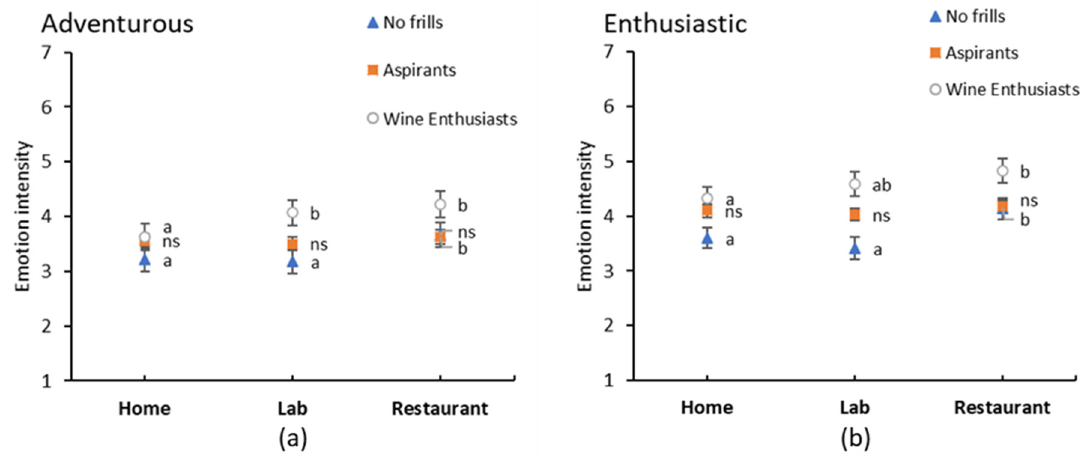
Figure 6. Interaction between fine wine segments (FWS) and context for ( a ) adventurous and ( b ) enthusiastic emotions. Error bars indicate standard errors. Different lowercase letters indicate significant differences between context within a FWS based on Fishers LSD post-hoc comparisons, ns—no significant differences.